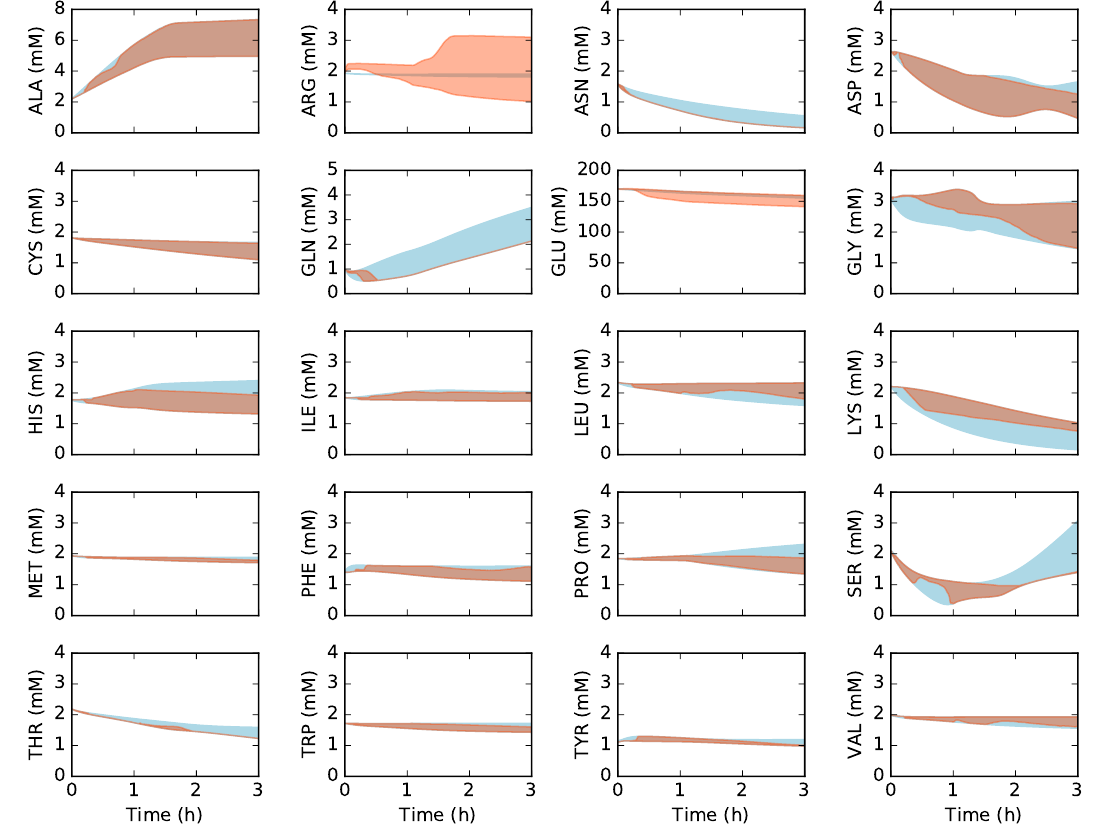
Figure 3. Simulation of amino acid concentration versus synthetic data as a function of time. The 95% confidence interval for the simulation conducted over the ensemble of transcription/translation parameter sets is shown in the orange shaded region, while the synthetic constraint data is shown in the blue shaded region. Arginine and glutamate were excluded from the constraint set. The synthetic data constraints were generated from the kinetic model of Horvath et al., which was trained using experimental measurements of the system simulated in this study [32].